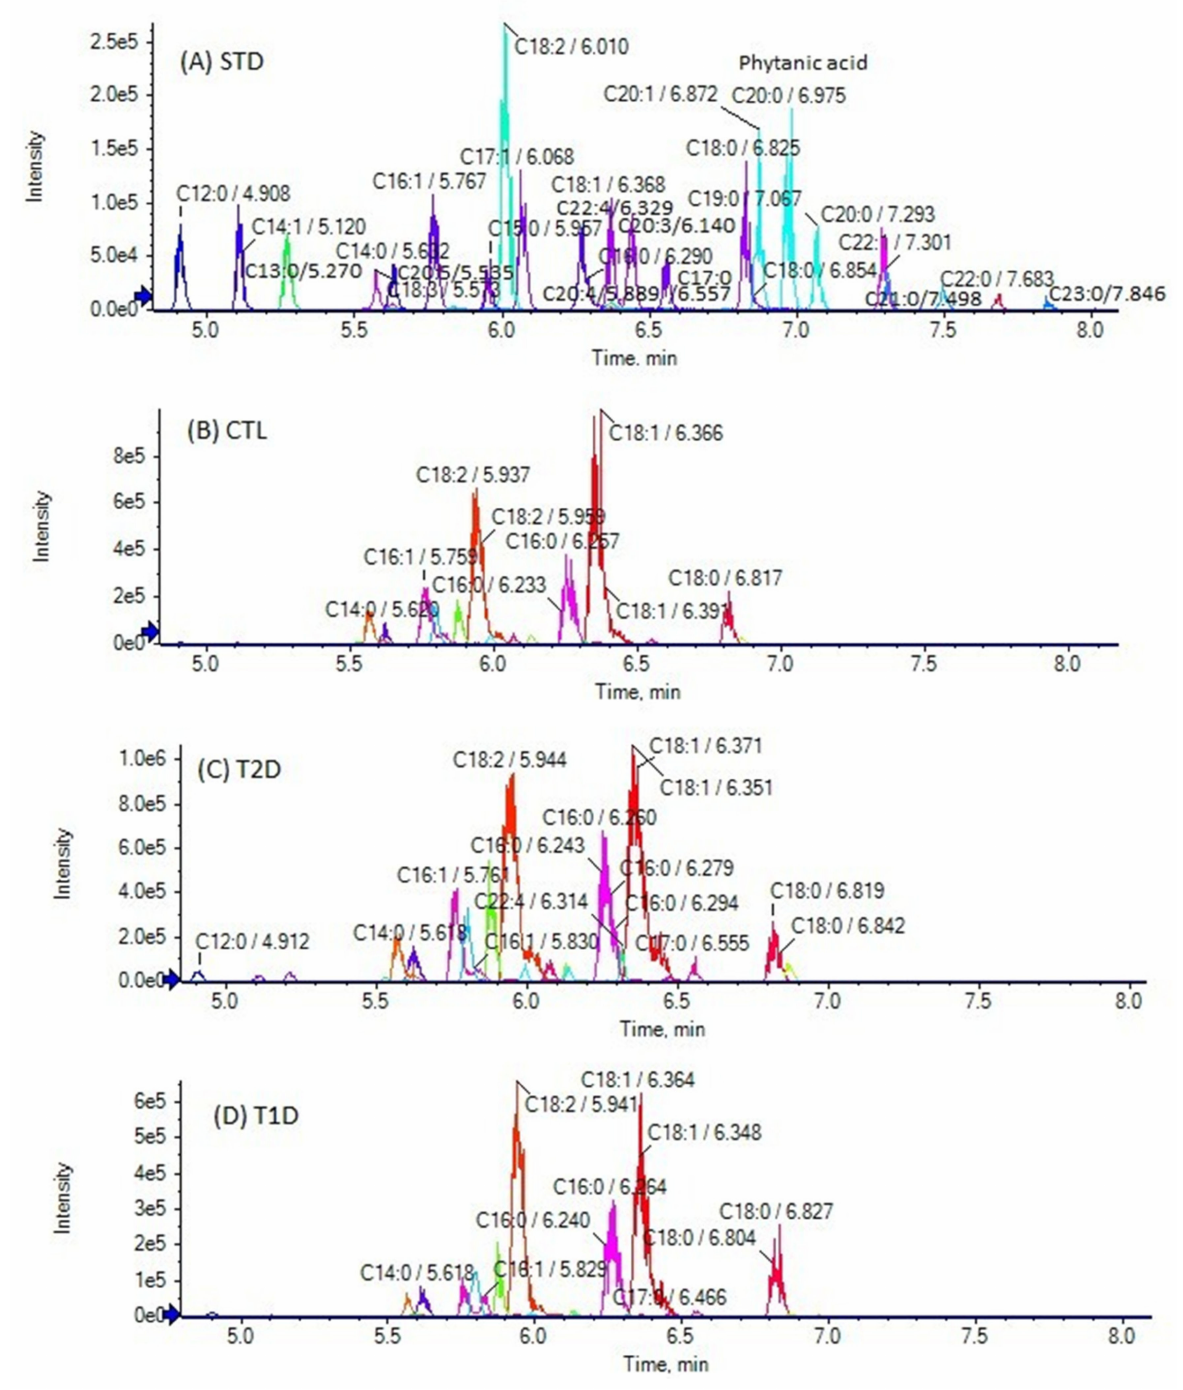
Figure 4. Extracted ion chromatograms (EICs) of FAs in a standard solution (500 ng/mL) ( A ), and in a representative control sample ( B ), a T2D sample ( C ) and a T1D sample ( D